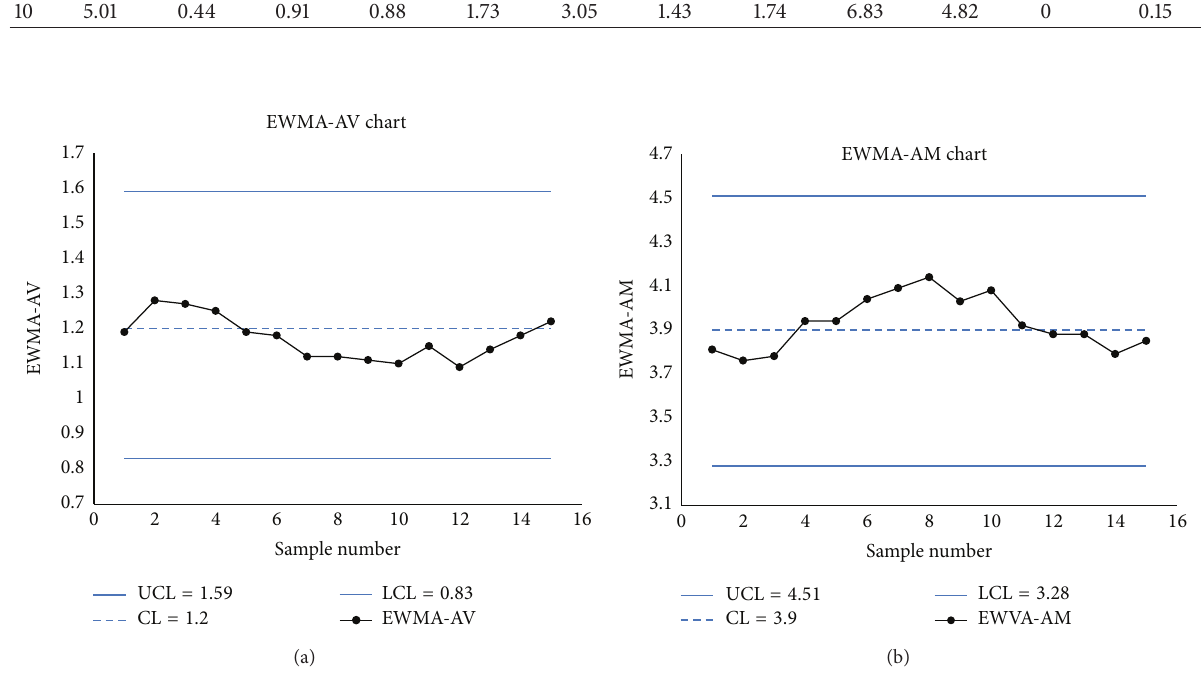
Figure 1: (a) The EWMA-AV chart. (b) The EWMA-AM